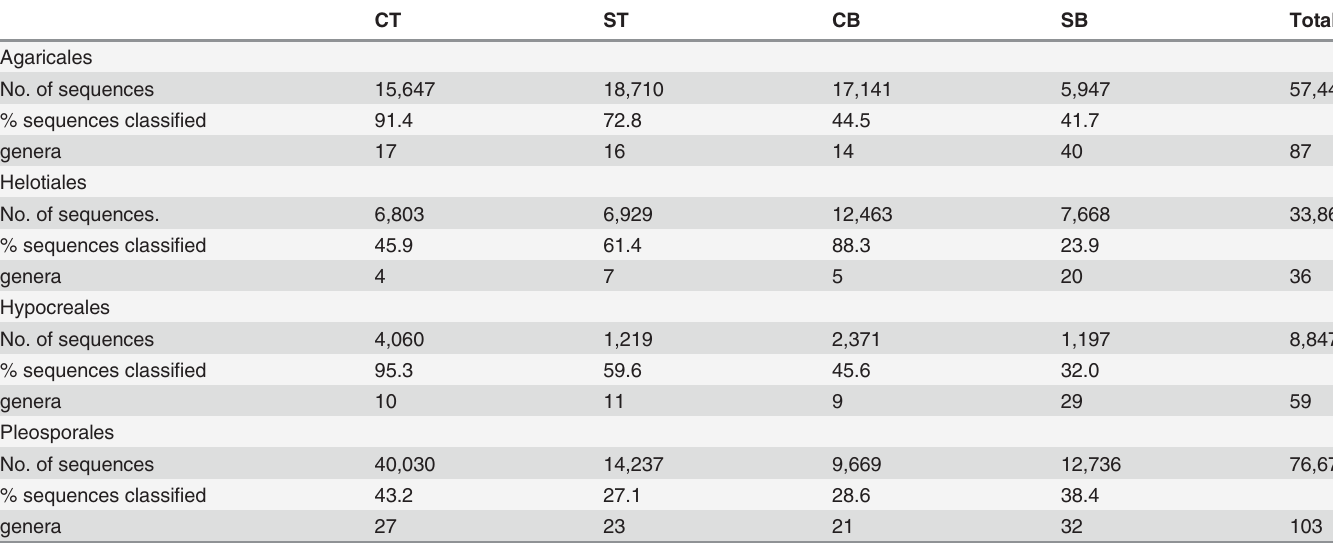
Table 5. The number of and percentage of sequences classi fi ed at the genus-level (with (cid:4) 80% con fi dence) within the four most abundant fungal orders detected in the composite libraries, as well as the number of genera they